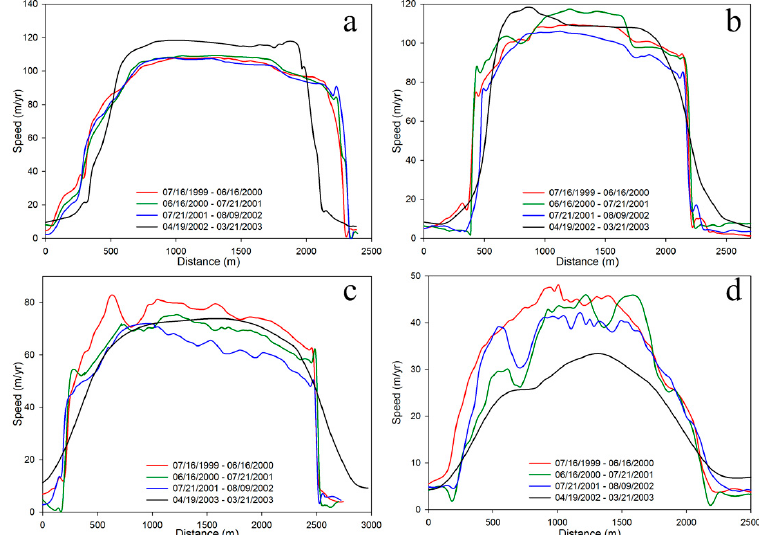
Figure 11. Transverse speed profiles of the Baltoro Glacier. Profile locations are depicted in Figure 3a. ( a – d ) The comparison of annual surface velocity change along the transverse profiles of T1, T2, T3, and T4, respectively.